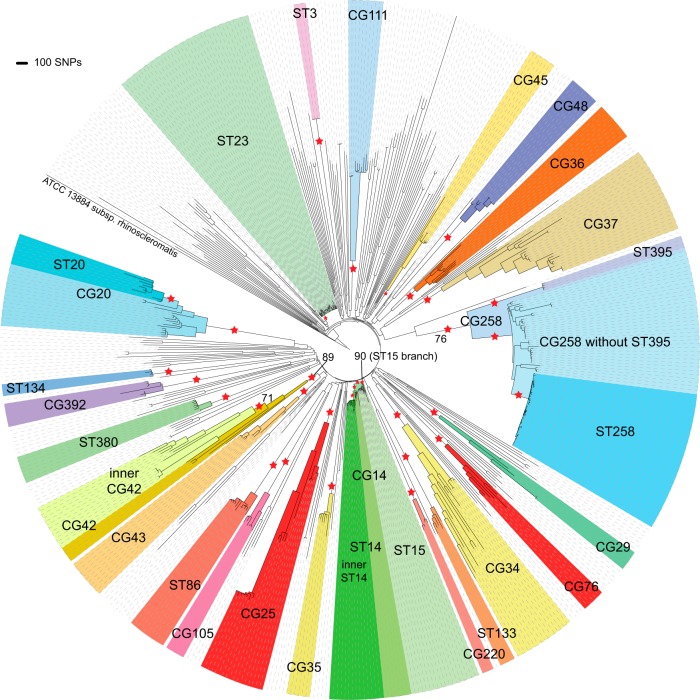
Maximum-parsimony tree with 100 bootstraps of the SNPs among 548 K. pneumoniae genomes. Major clonal groups are colored, and locations of canSNPs for strain identification assays are marked with stars. All of the branches labeled with canSNPs had >99% bootstrap support, except for the three branches indicated.